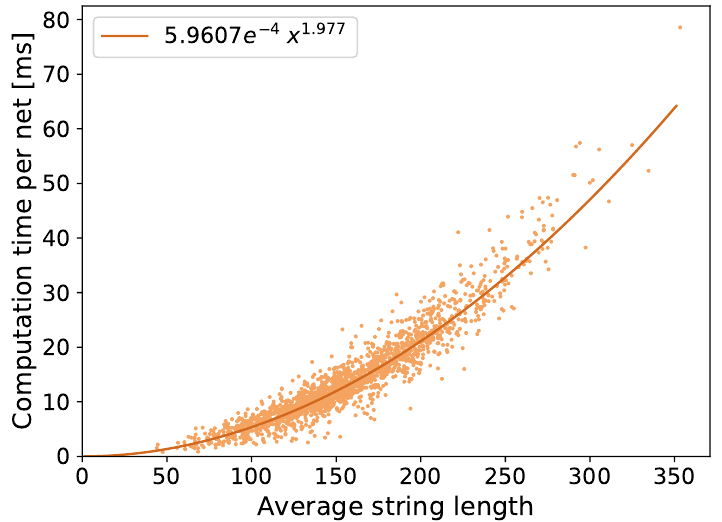
Figure 10. Computation time per net as a function of the average string length in the pair of OTA layouts. A power-law fit is also shown. The coefficient of determination R 2 ≈